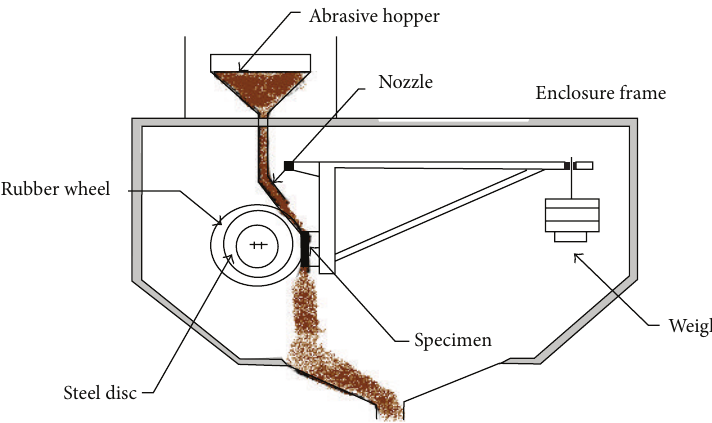
Figure 1: Schematic diagram of dry sand rubber wheel abrasion tester.